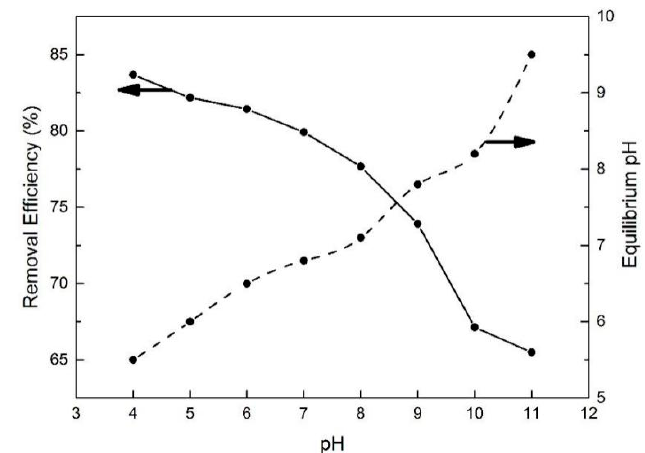
Figure 10. E ff ect of pH on removal e ffi ciency and equilibrium pH (experimental conditions: initial